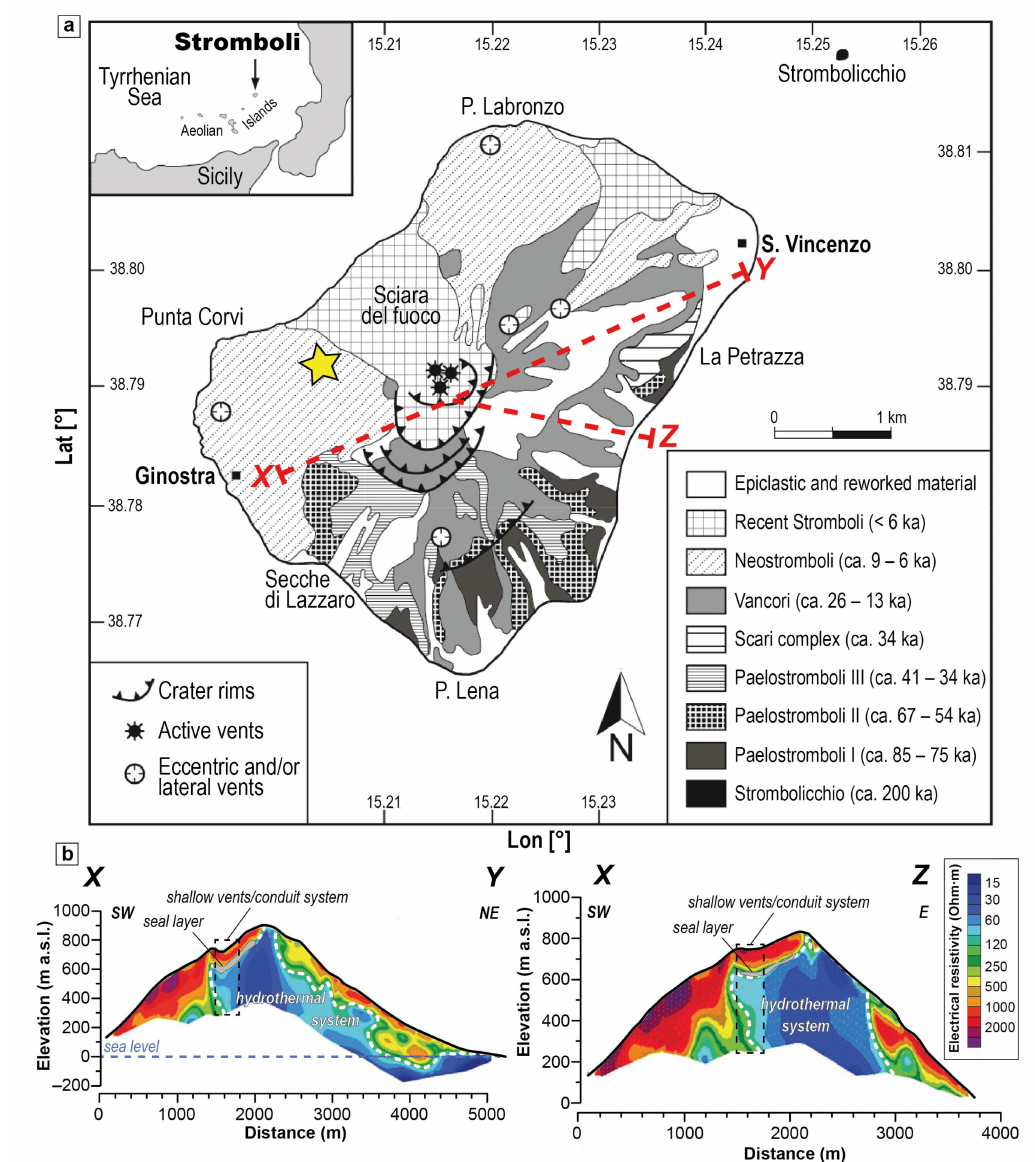
Figure 3. ( a ) Simplified geological map of the Stromboli volcano (modified after [33]). Neostromboli interval of activity is also in agreement with recent stratigraphic and volcanological reconstruction of Vezzoli et al. [42] and new paleomagnetic datings of Risica et al. [43]. The yellow star indicates the sampling point of the B1 porcellanite–buchite xenolith that was erupted during the 5 April 2003 paroxysm of Stromboli; red dashed lines represent the cross–sections X–Y and X–Z reported in ( b ); Lat[ ◦ ] and Lon [ ◦ ] stand for Latitude and Longitude in decimal degrees, respectively (coordinate system WGS84); ( b ) DC resistivity tomograms (in ohm · m) along two profiles of Stromboli volcano (X–Y and X–Z) emphasize the extension of the hydrothermal system outlined by low values (15–50 ohm · m) of electrical resistivity (redrawn from [44]). The shallow vents/conduit system is emphasized by a dashed rectangle, it being the place where the igneous pyrometamorphic processes of Stromboli, as those described for the investigated B1 xenolith, may commonly